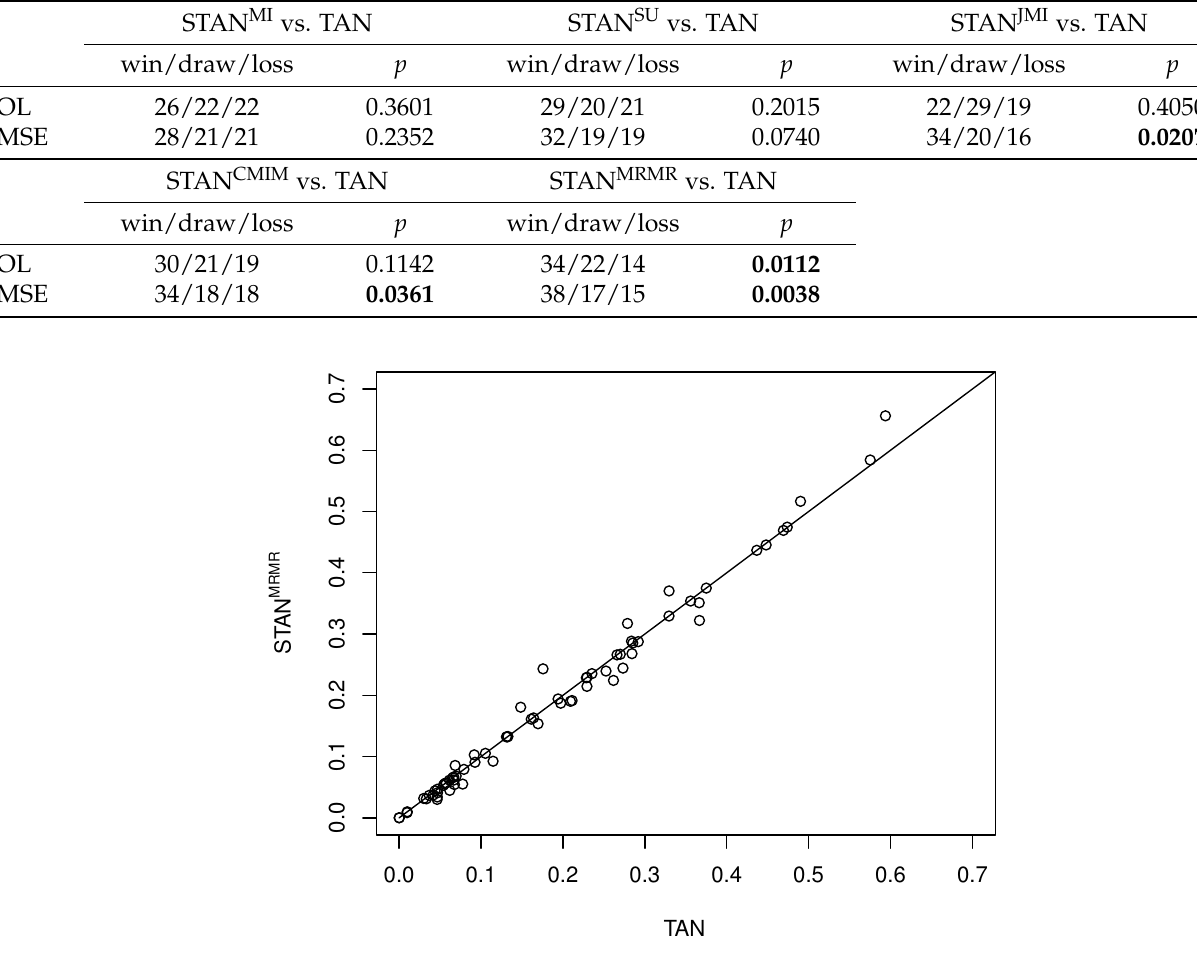
Figure 2. Scatter plot of STAN MRMR to TAN in terms of